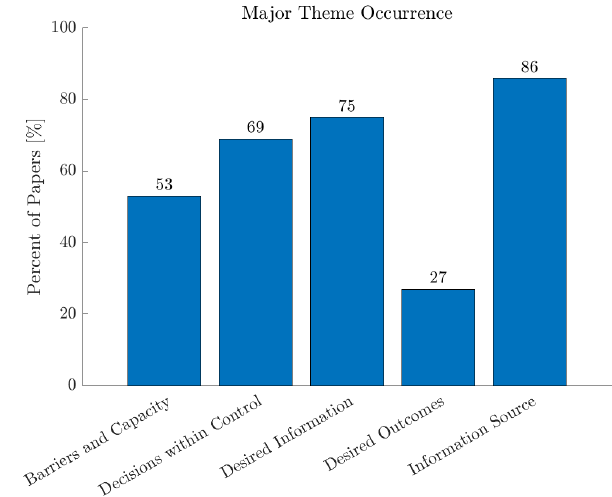
Figure 5. The relative frequency (percent of documents) with which each major theme occurs throughout the document